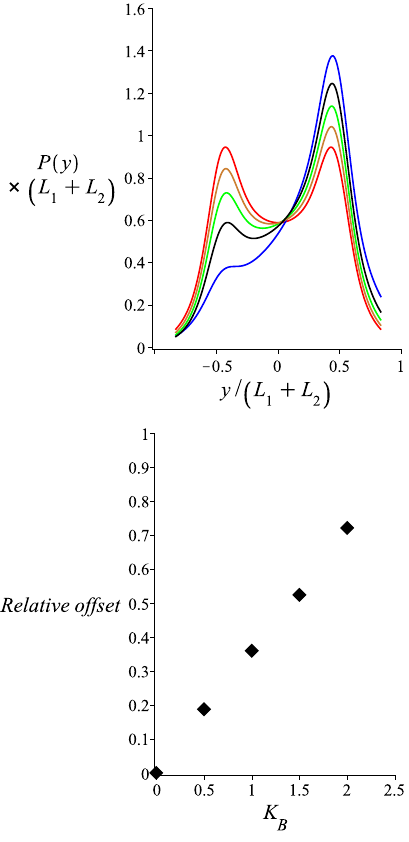
Figure 7. Upper panel: The probability density of the y coordinate of the position of the tip of two filaments jointed at a hinged point, as shown by Equation (16). The red, gold, green, black and blue colours correspond to K B = 0.005, K B = 0.5, K B = 1, K B = 1.5 and K B = 2, respectively. Lower panel: The relative offset in the heights of the two peaks in the bimodal profile function of the magnetic energy K B (measured in units of k B T ). The fixed parameters for all curves are: l p 1 = l p 2 = l p = 27 µ m; L 1 = 3 µ m; L 2 = 3 µ m; ω = 0; θ B = π